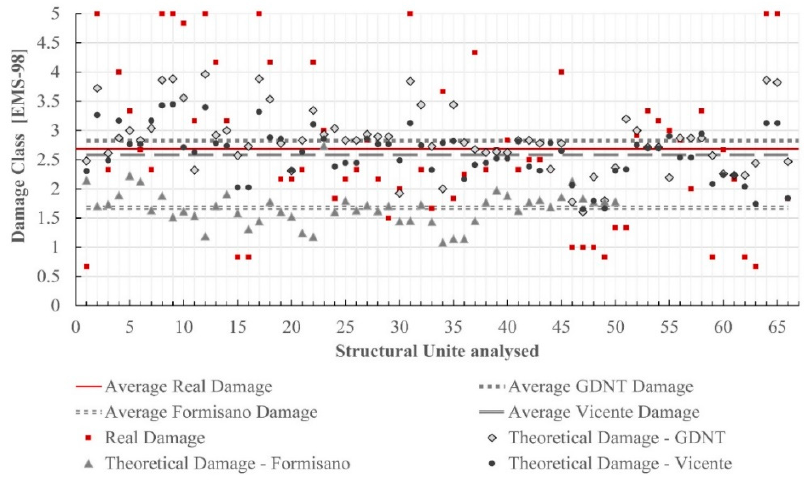
Figure 14. Comparison between the real damage detected in the case study and the theoretical damage evaluated through different vulnerability methodologies for each